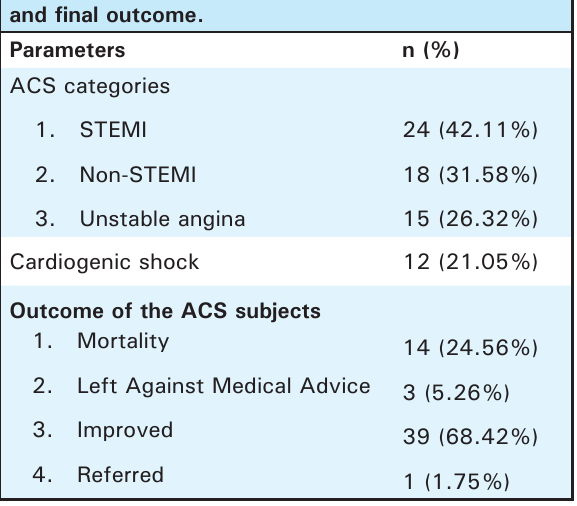
Table 2. ACS categories among admitted subjects and fi nal outcome.